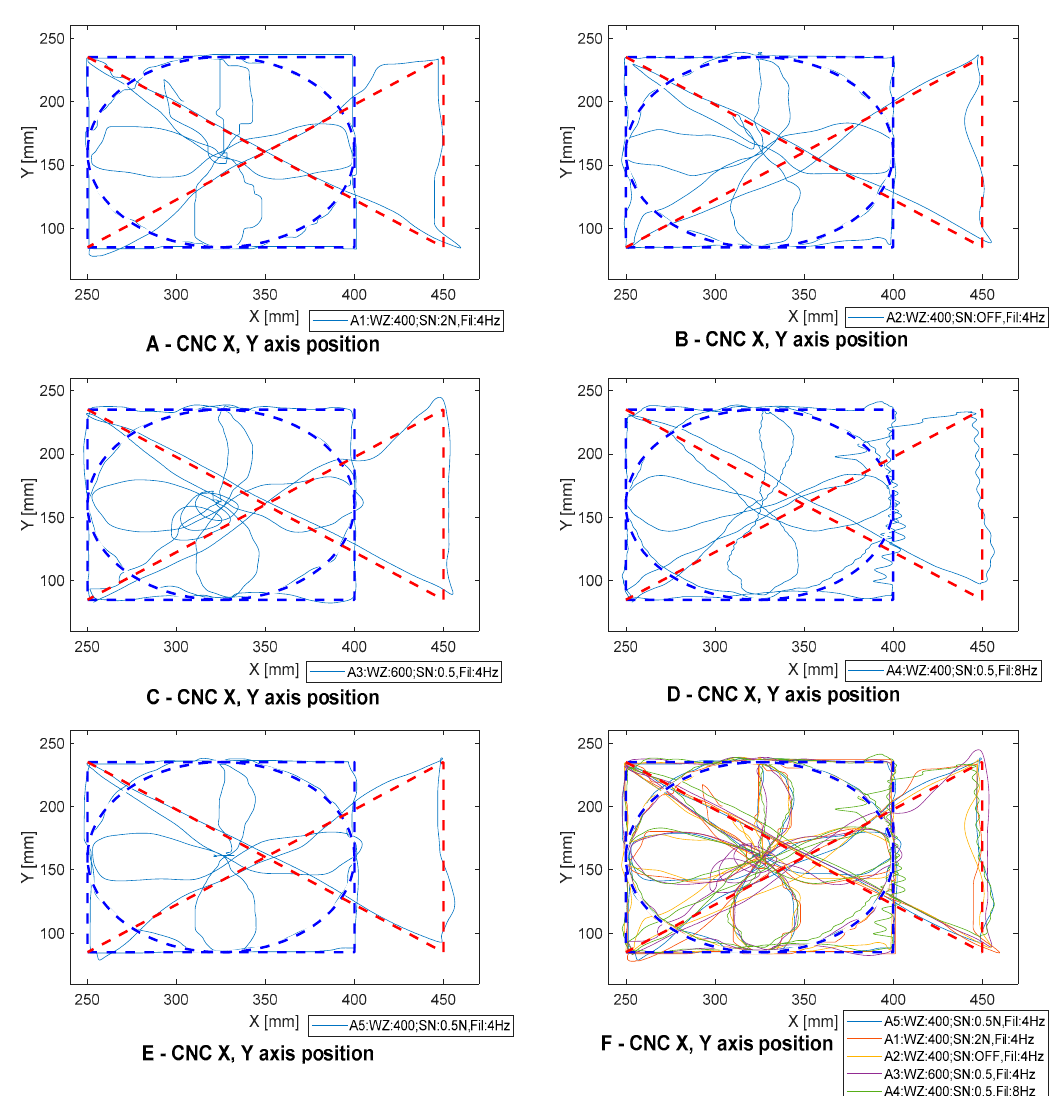
Figure 10. System calibration for first operator.